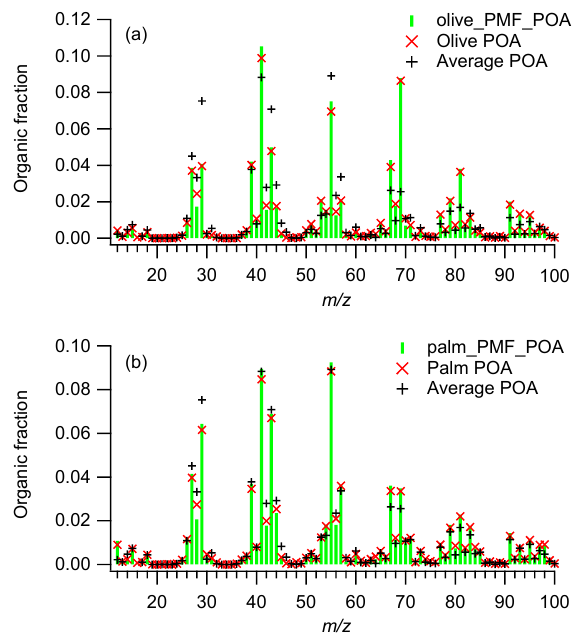
Figure 4. Mass spectra of POA emissions and PMF-derived POA factors for (a) olive and (b) palm oil and, for comparison, the aver- age mass spectrum of POA emissions from sunflower, peanut, corn, and canola oils obtained from Liu et al. (2017).